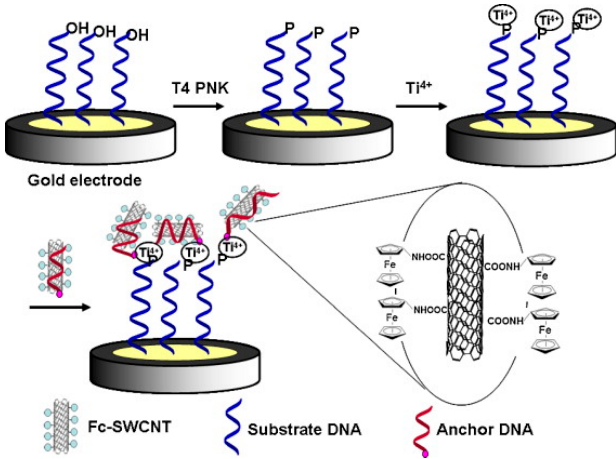
Figure 2. Schematic illustration of the electrochemical assay for the detection of kinase activity using DNA/Fc-single-walled carbon nanotubes (DNA/Fc-SWCNTs) and Ti 4+ . See the text for more information. Reprinted from [7] with permission.